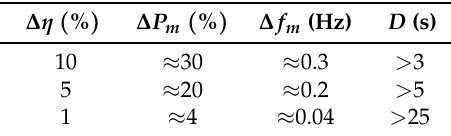
Table 4. Precision on frequency